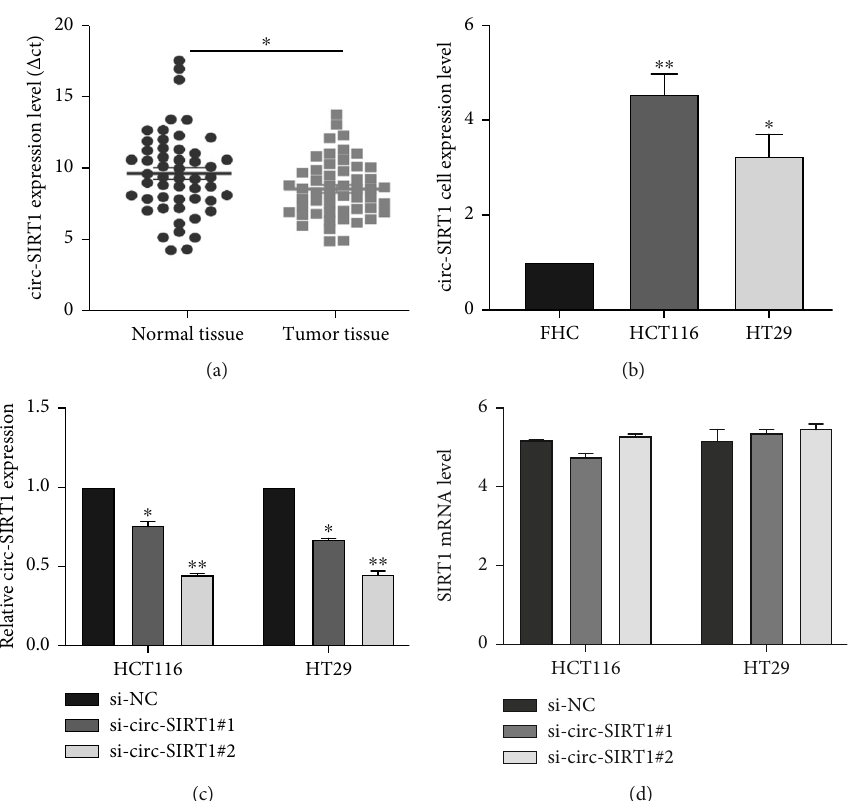
Figure 1: circ-SIRT1 was upregulated in colorectal cancer tissues and cells. The relative expression of circ-SIRT1 in human CRC tissues and matched normal colorectal tissues (a). The expression level of circ-SIRT1 in FHC, HCT116, and HT29 cell lines (b). circ-SIRT1 was e ff ectively knocked down in HCT116 and HT29 cells transfected with si-circ-SIRT1 (c). Expression of SIRT1 in HCT116 and HT29 cells transfected with si-circ-SIRT1 (d). ∗ stands for P < 0 : 05 , ∗∗ stands for P < 0 : 01 . Table 1: The relationship between the expression level of circ-SIRT1 in colorectal cancer and clinical factors. Clinical factors